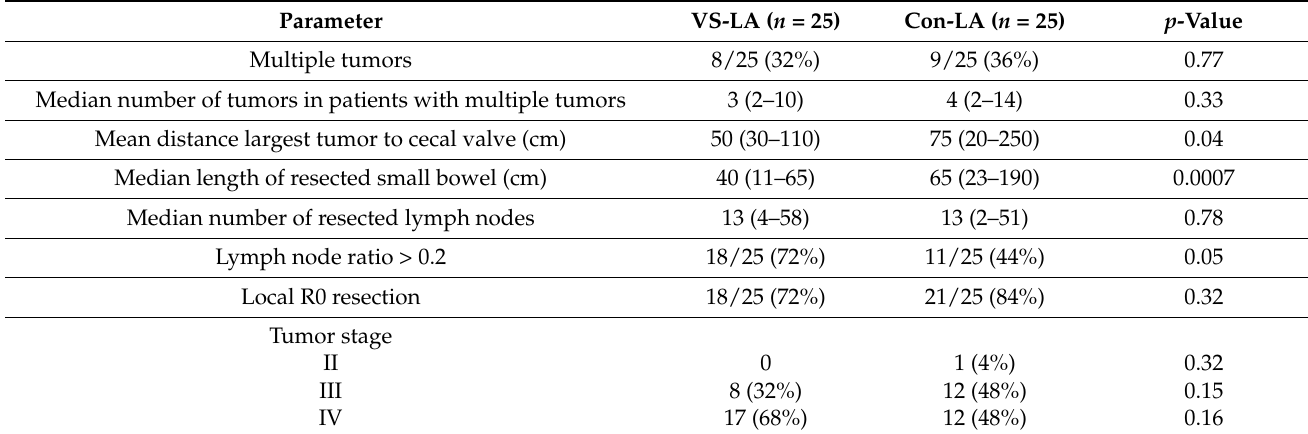
Table 2. Pathological findings after small bowel resection for